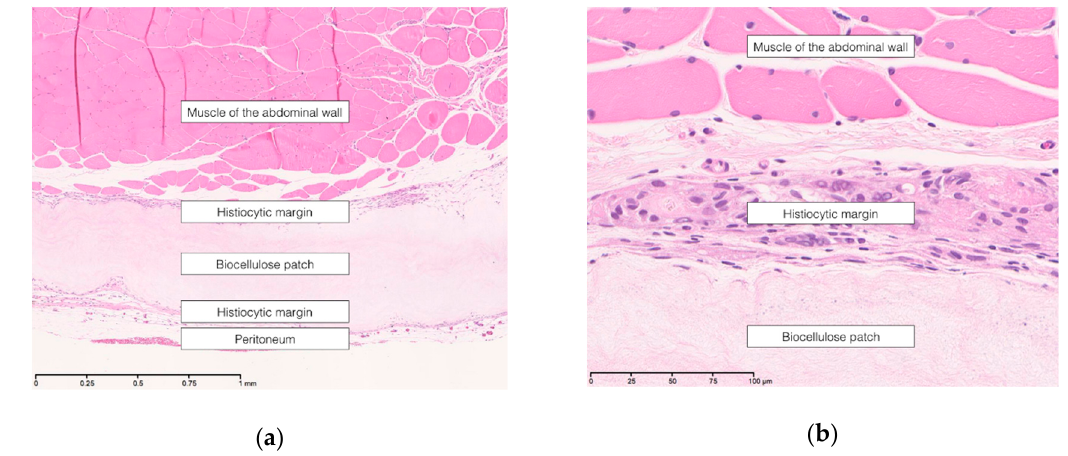
Figure 4. Hematoxylin-eosin staining showing the histiocytic margin and the patch in the sublay model, ( a ) 100-fold magnification; ( b ) 200-fold magnification. This was confirmed by the Elastica-van-Gieson